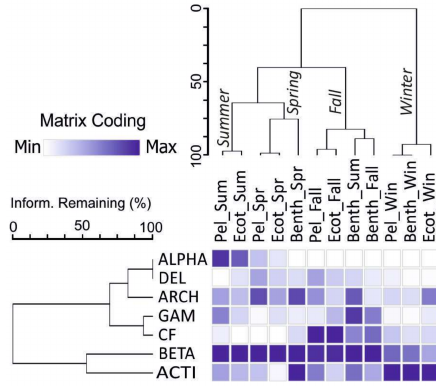
Figure 6. Two way cluster analysis exposing relationship between clusters of Eubacteria-Archaea and seasons and sites. Heat map colors indicate minimum (white) to maximum (navy blue) abundances in samples, wherein colors are scaled by a relative abundance in a